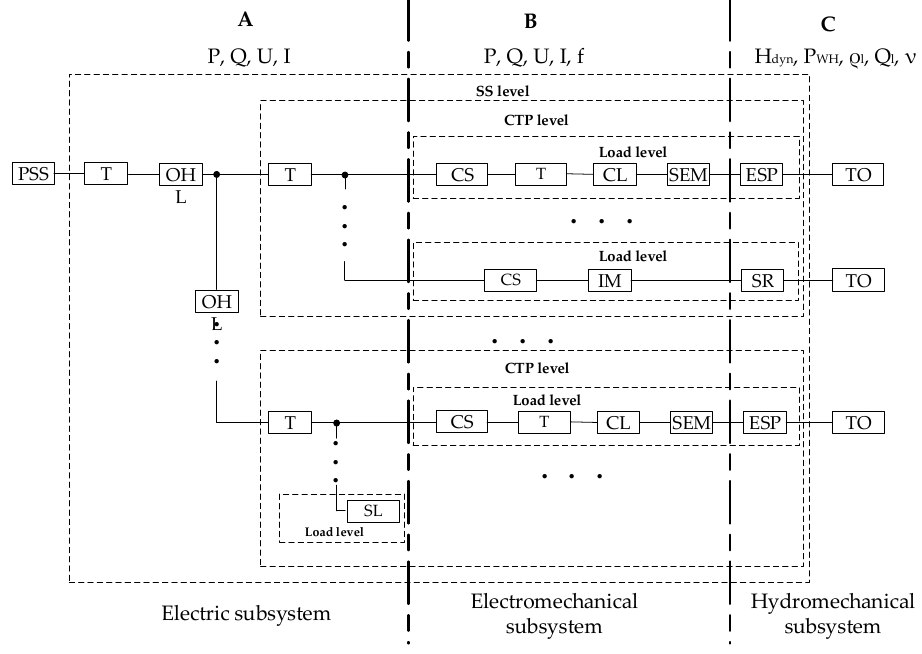
Figure 1. Scheme of OF ETC.